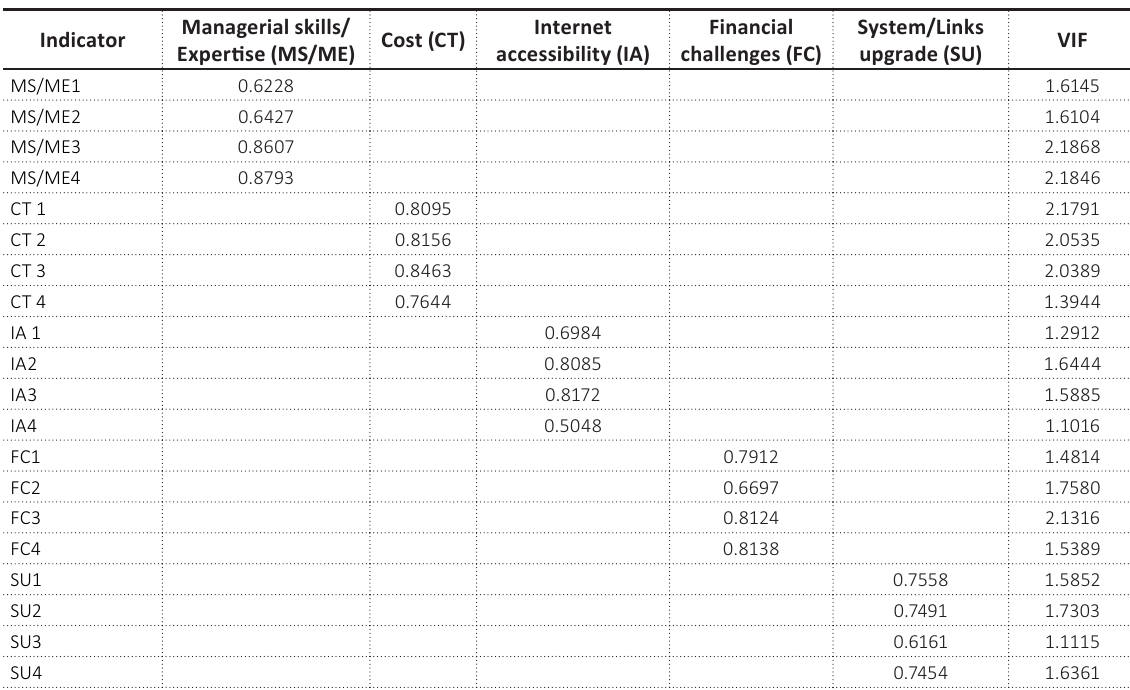
Table 4. Factor loading and variance inflation factor